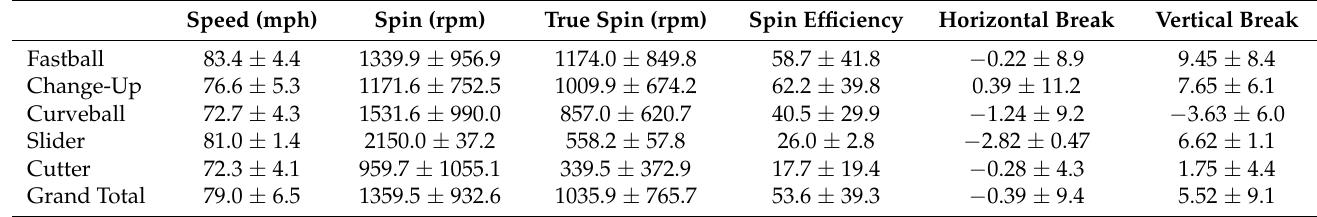
Note: bold and shaded indicates significant association ( p < 0.05). Red shaded cells indicate a strong association (0.7 to 1.0) between measures, orange shaded cells indicate a moderate association (0.4 to 0.69), and yellow shaded cells indicate a weak (<0.4) association. Table 4. Pitch Performance Metrics. Metrics displayed in mean ± SD and reporting directly from Rapsodo software program. Definitions are taken directly from the user manual (Rapsodo, Inc., Pitching 2.0: User manual; see Supplemental Material). Speed (mph) indicates how fast a pitch is traveling during flight. Spin rate is the rate at which the ball spins during flight. True spin is the spin directly impacting the movement of a pitch. Also known as “useful spin,” it is perpendicular to the direction the ball is traveling, deflecting the otherwise straight horizontal and vertical path of the ball. Spin efficiency is the percentage of spin directly impacting the movement of a pitch; spin efficiency is the ratio of true spin to total spin. Horizontal and vertical break represent how much a ball has moved when it crosses the strike zone compared to what its position would have been without